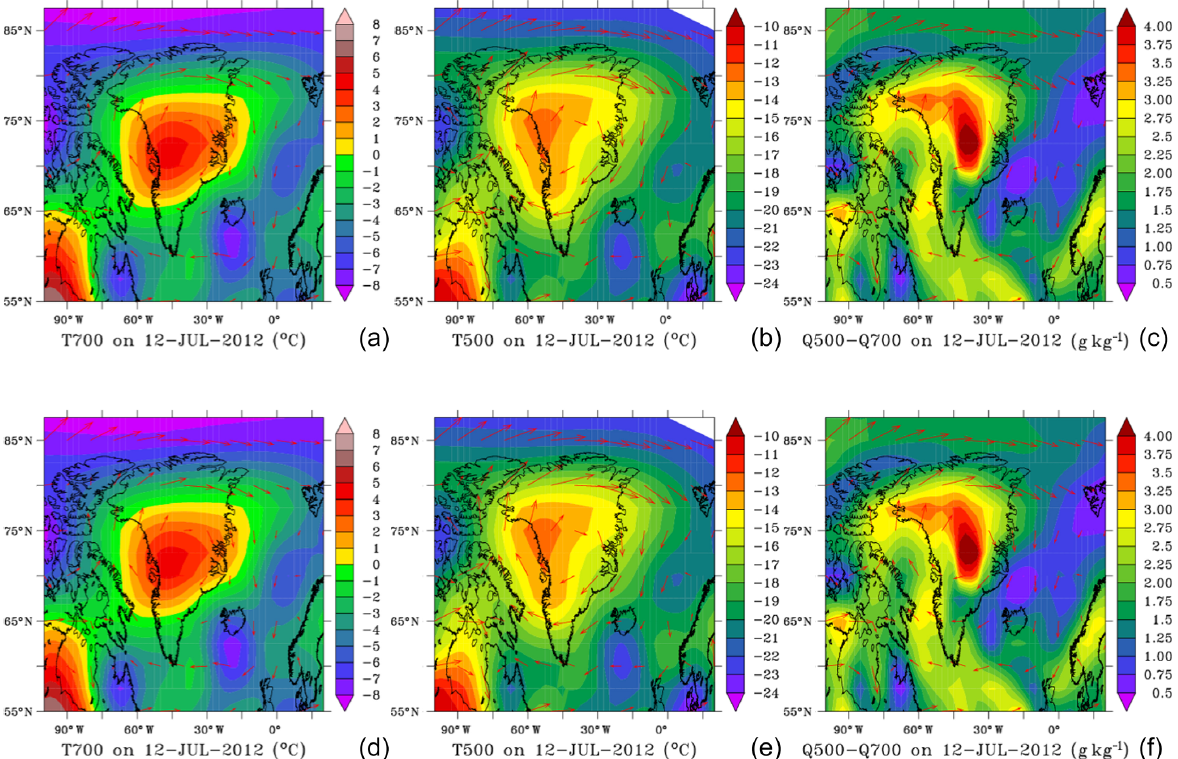
Figure 11. Absolute values of the temperature at (a, d) 700hPa (T700) and (b, e) 500hPa (T500) and (c, f) mean specific humidity over 700–500hPa from NCEP/NCARv1 reanalysis on 12 July 2012 (a, b, c) and on 31 July 2019 (d, e, f) .